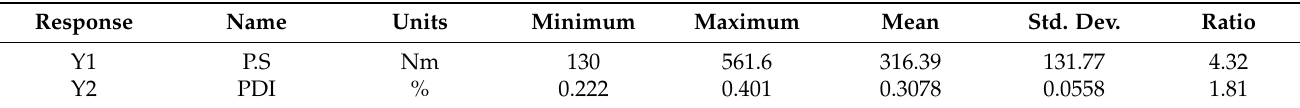
Table 6. Summary of 15 runs of formulations.